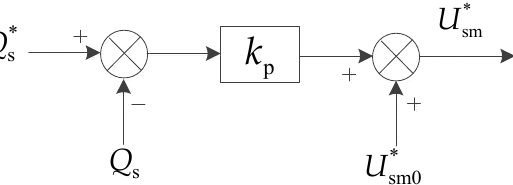
Figure 14. The V generator block diagram of the PV-type grid-forming nonsynchronous-machine source.